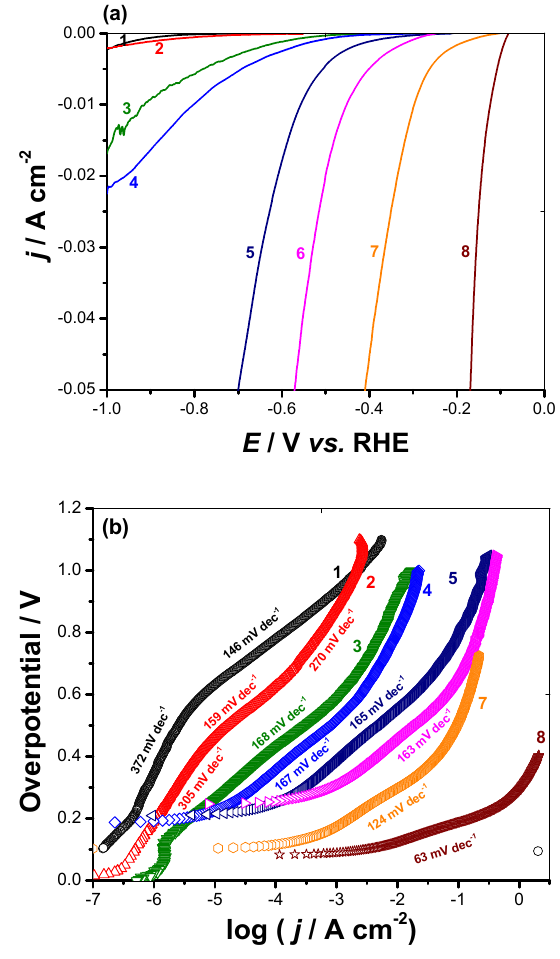
Figure 8. Linear cathodic polarization curves ( a ) and the corresponding Tafel plots ( b ) recorded for the investigated catalysts. Measurements were conducted in deaerated 0.1 M KOH solution at a scan rate of 5.0 mV s − 1 at room temperature.(1) bare GC electrode (unactivated); (2) bare GC electrode (activated); (3) GC-FA (unactivated); (4) GC-FA (activated); (5) GC-TiO 2 (unactivated); (6) GC-TiO 2 (activated); (7) GC-(FA-TiO 2 ) (unactivated); (8) GC-(FA-TiO 2 )